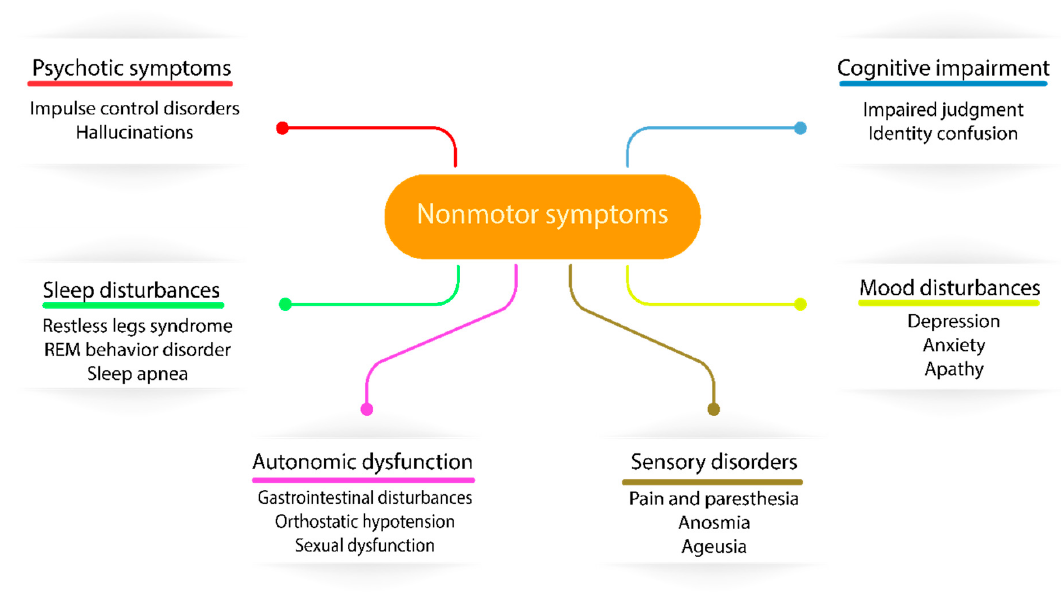
Figure 1. The diverse nature of nonmotor symptoms affecting Parkinson’s disease (PD) patients .